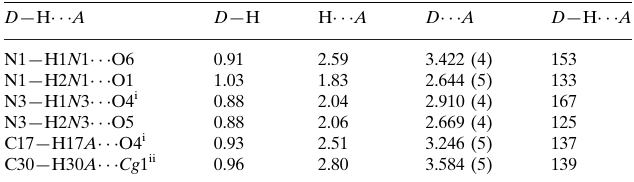
Data collection Bruker APEXII DUO CCD area- detector diffractometer